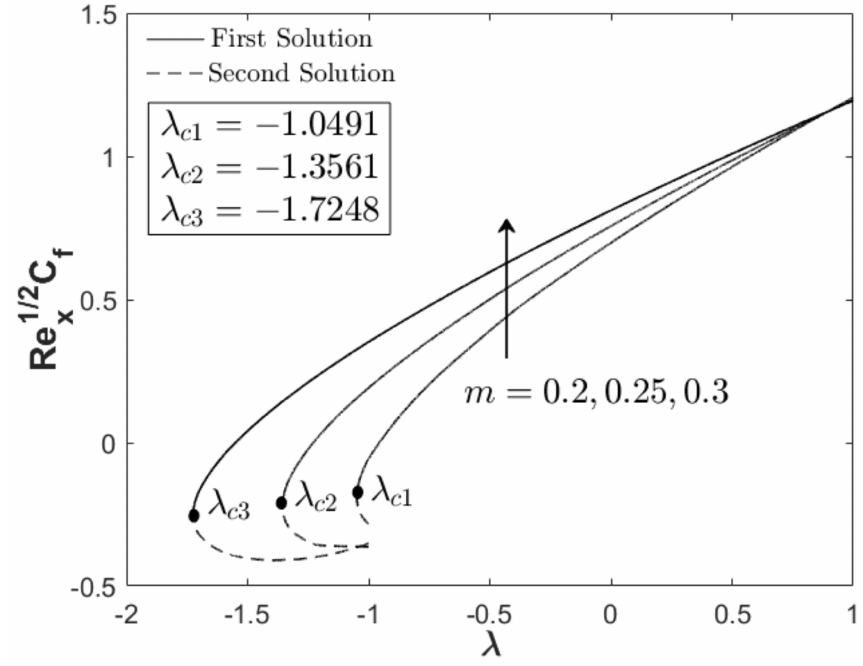
Figure 2. Re 1/2 x C f towards λ when S = 0.05, φ hnf = 0.02, and different m .